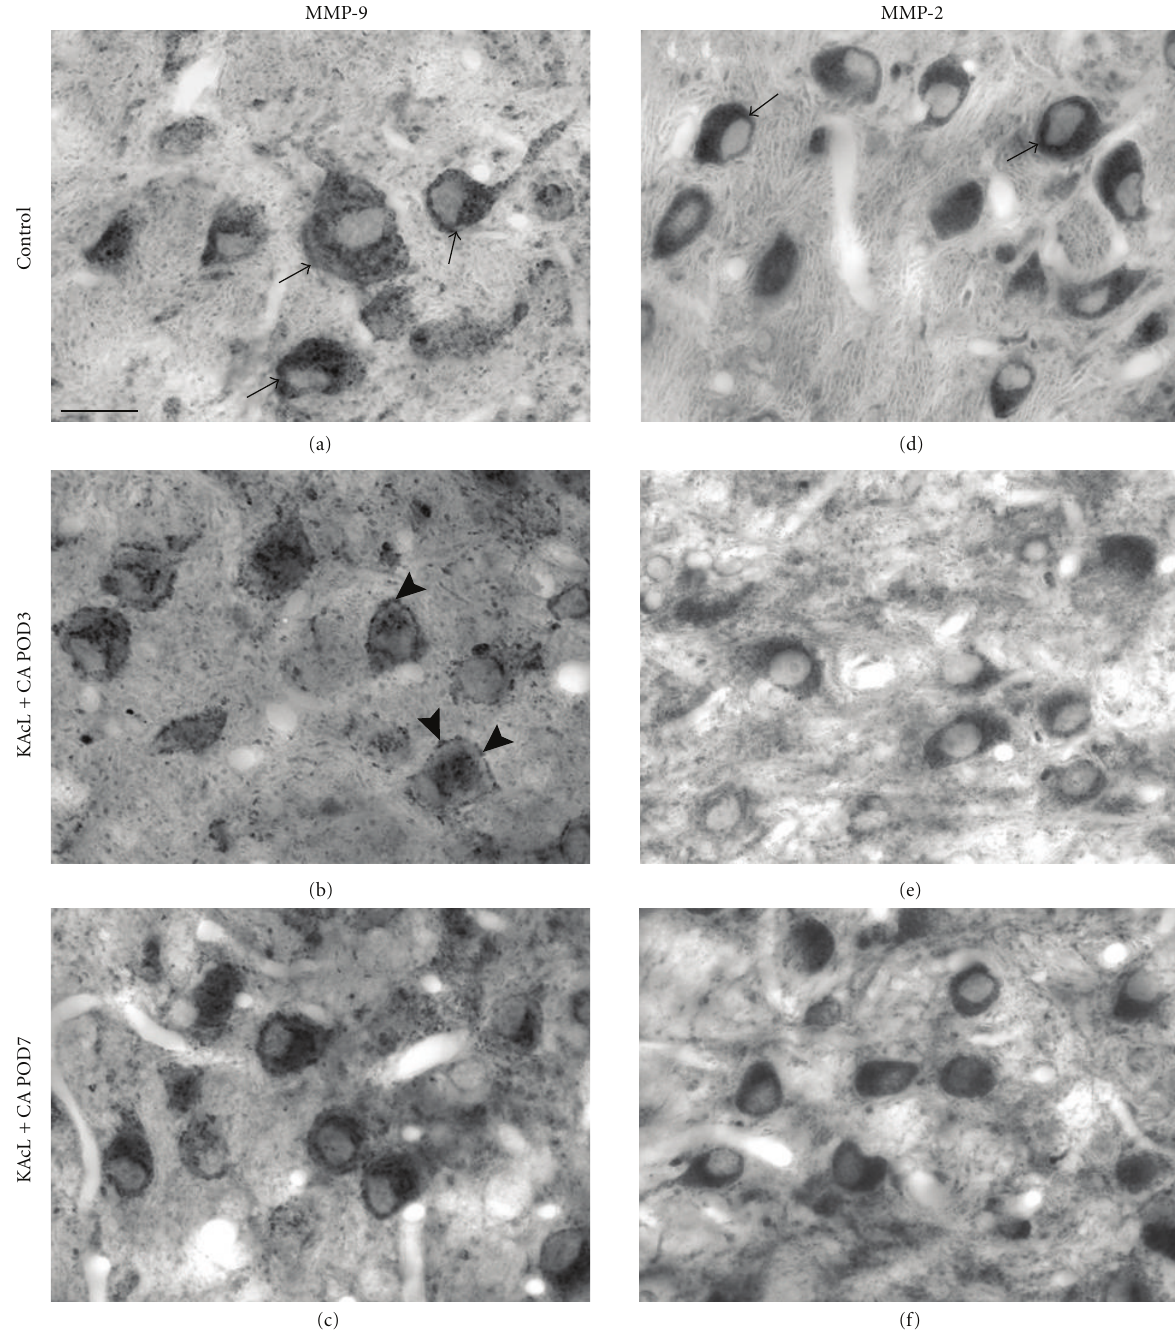
Figure 5: Time course of the distribution of MMP-9 and MMP-2 following combination of KA injection completely lesioning VNTB and cochlear ablation (KAcL + CA). (a)–(c) The distribution of MMP-9 showed no di ff erences compared to the pattern following cochlear ablation alone (Figure 1(a)–1(d)). Compared to control animals (a), the cytoplasm of AVCN neurons (arrows in (a)) have lost MMP- 9 by POD3 (b) but regained it till POD7 (c). Beaded collars close to the plasma membrane were particularly prominent around POD3 (arrowheads in (b)). (d–f) As in case with cochlear ablation alone (Figures 1(e)–1(h)), the cytoplasm of AVCN neurons partially lost their MMP-2 immunoreactivity by POD3 (e). By POD7, MMP-2 immunoreactivity in cytoplasm of neurons was almost back to control level (d) again (f). Scale bar: 20 μ m. Global contrast adjustment was identical for all photographs in this